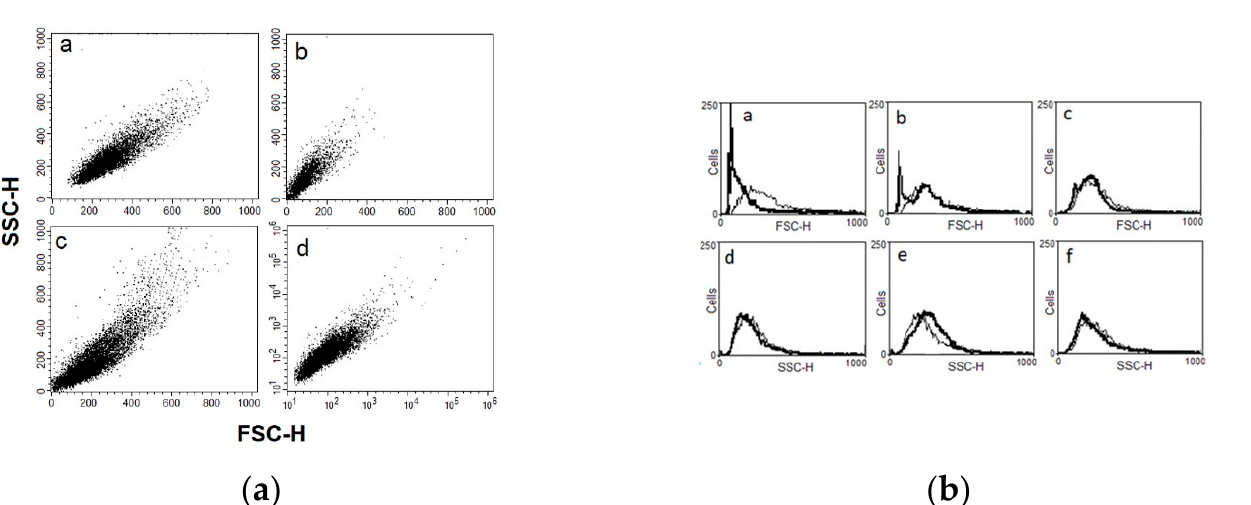
Figure 5. Analysis of phosphatidylserine (PS) extracellular exposure. Representative dot plot of FACS analysis for PS exposure, measured by double staining with Annexin V-FITC and propidium iodide (PI) in T. cruzi epimastigotes after 72 h treatment with Nifurtimox (Panel b ), ST18 (Panel c ) and TR4 (Panel d ). Non-treated control is represented in (Panel a ). Lower-left quadrant represents control cells (Annexin V negative/PI negative), lower-right quadrant represents early apoptotic cells (Annexin V positive/PI negative), upper-right quadrant represents late apoptotic cells (An- nexin V positive/PI positive) and upper-left quadrant represents necrotic cells (Annexin V nega- tive/PI positive). Data are representative of three separate experiments.